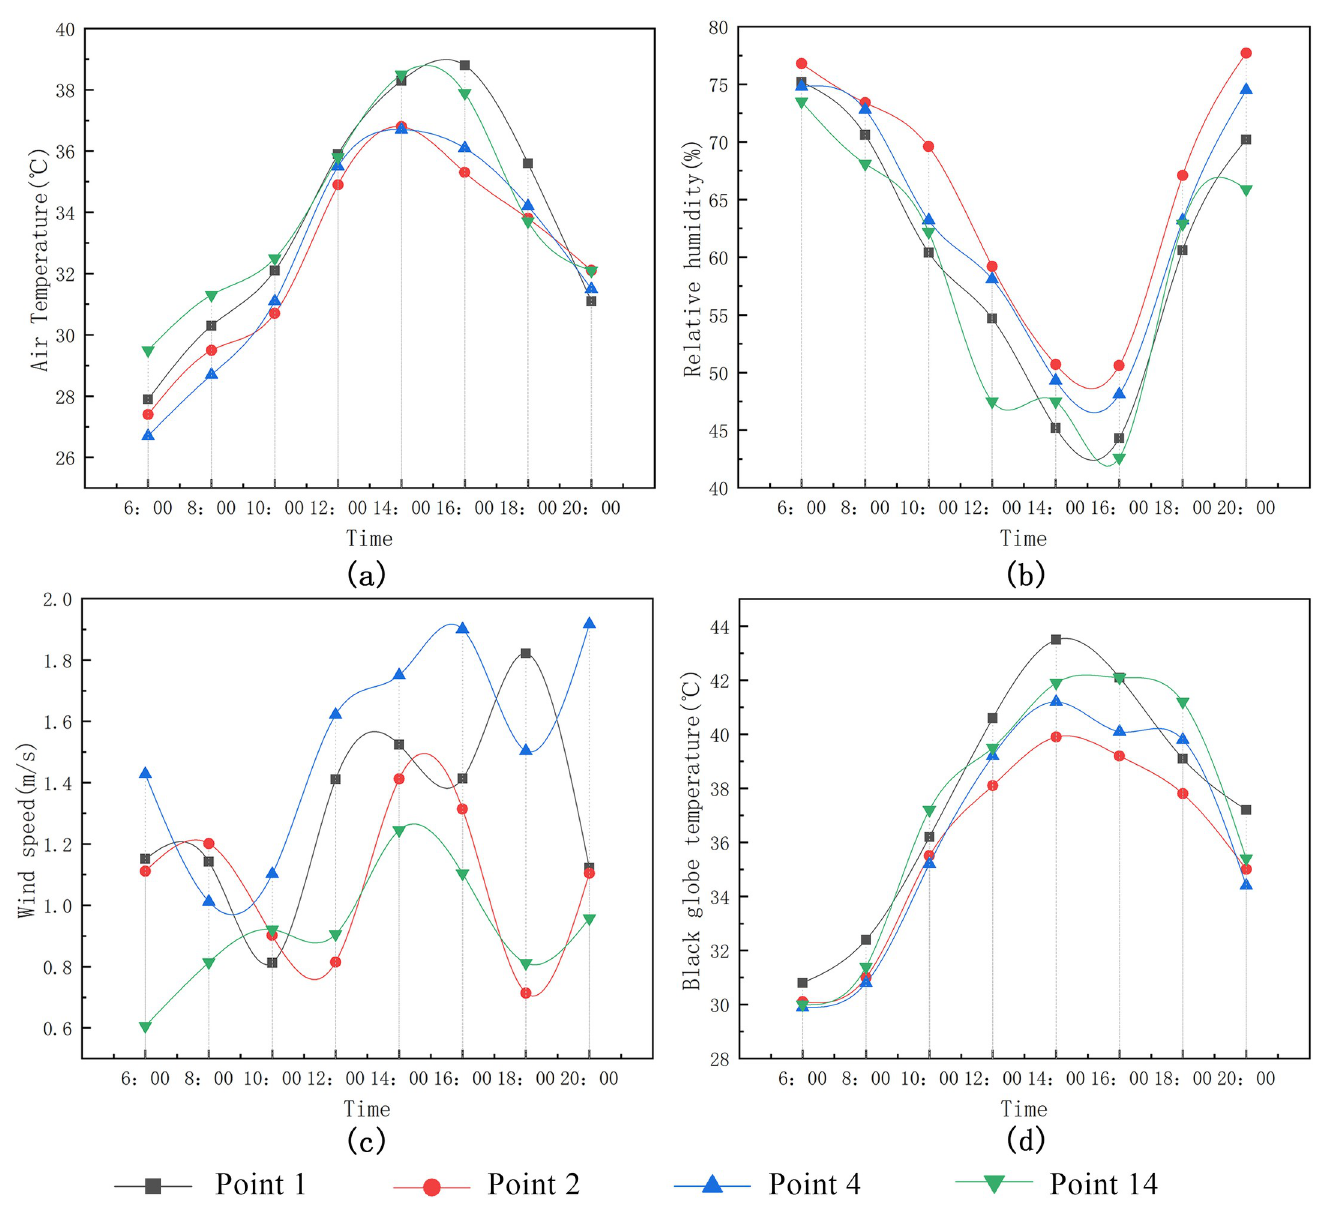
Fig 11. Variation trends of microclimate parameters at each measurement point in the square.